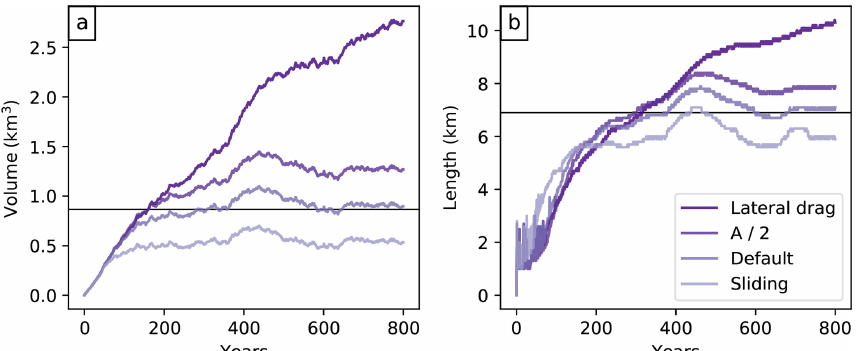
Figure 8. Evolution of volume (a) and length (b) of Hintereisferner Glacier under a random climate forcing generated by shuffling the “climate years” representative for the 31-year period centered on t ∗ . The glacier is reset to zero for each simulation, and the bed topography is obtained using the default parameters. The sensitivity to the addition of a sliding velocity or to a halving of the creep parameter A are also shown. The noisy patterns of the length time series are due to the fact that the length of a glacier on a discrete grid is sensitive to small interannual